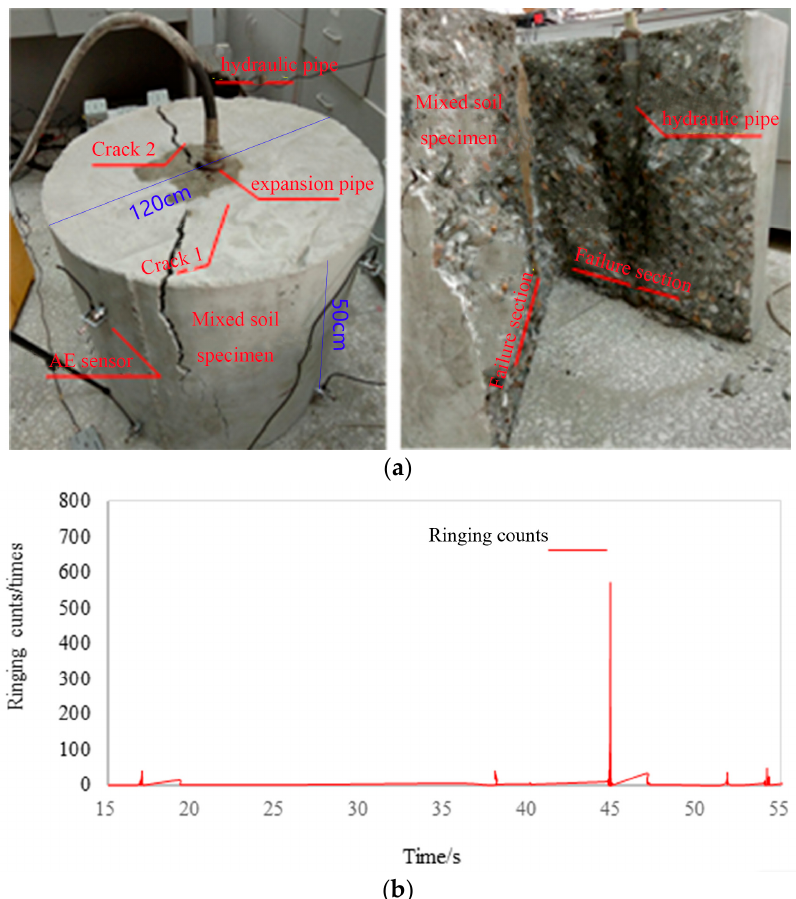
Figure 11. Monotonous load splitting diagram. ( a ) Crack propagation diagram of rock; ( b ) Cracking AE signal.